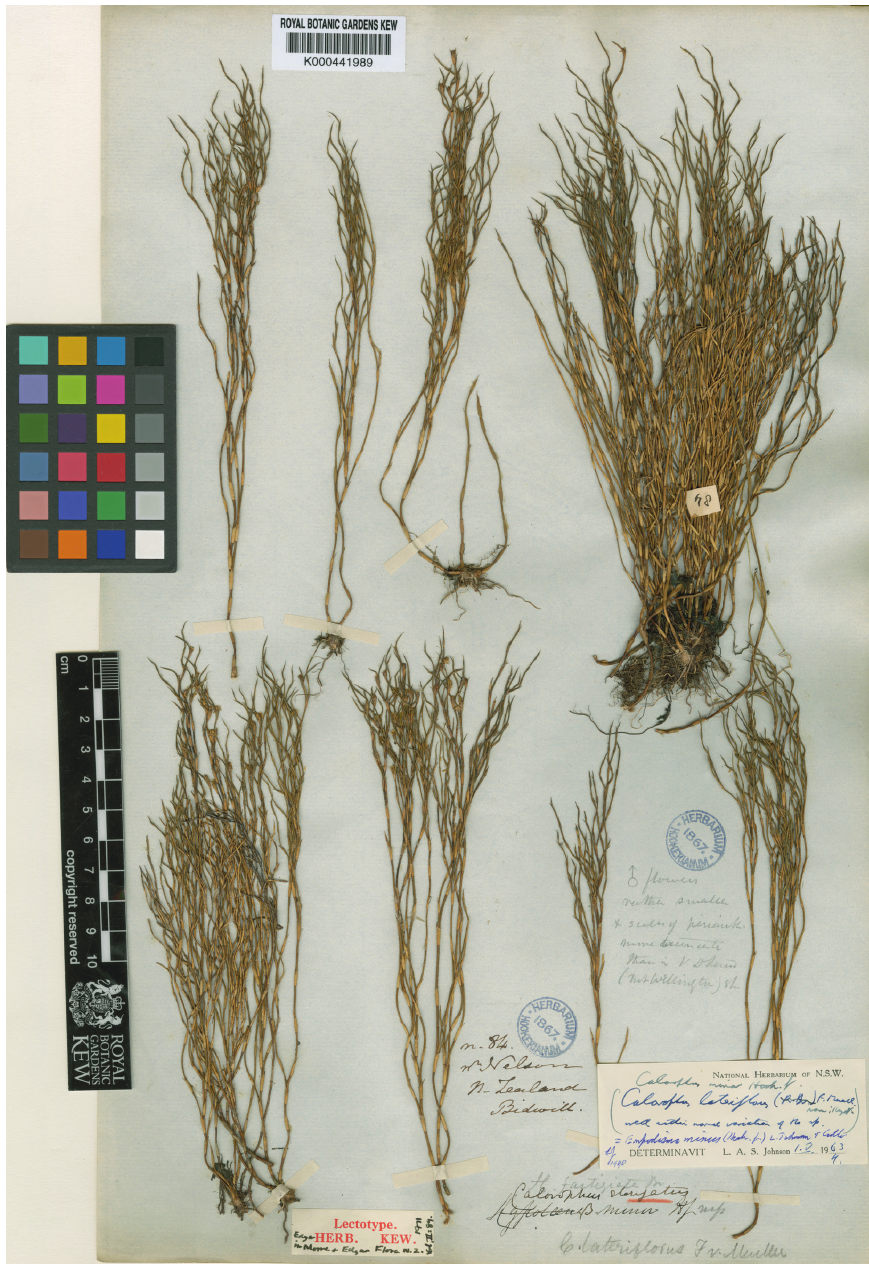
Figure 10. High resolution photograph of the lectotype of Empodisma minus (Hook.f.) L.A.S. Johnson & D.F.Cutler. Reproduced with the consent of the Royal Botanic Gardens, Kew, © The Board of Trus- tees of the Royal Botanic Gardens. Hooker (1853) described the new species Calorophus minor Hook.f. based upon Bidwell, Colenso and Lyall specimens. A specimen collected near Nelson by Bidwell, no. 84, K000441989, was chosen as the lectotype by Moore and Edgar